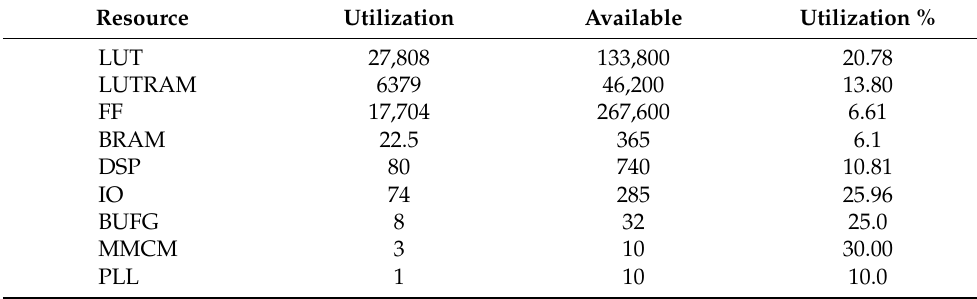
Table 4. Digilent’s Nexys Video Artix-7 FPGA resource